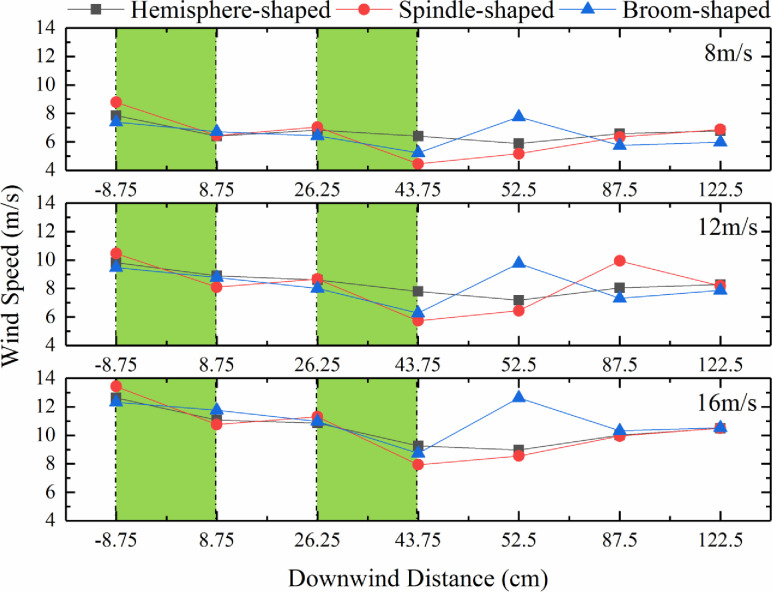
Effect of synthetic shrub design on wind speed.(The green shading represents an obvious downward trend in wind speed).